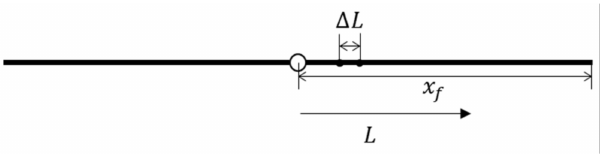
Figure 6. The Segmentation of Fracture